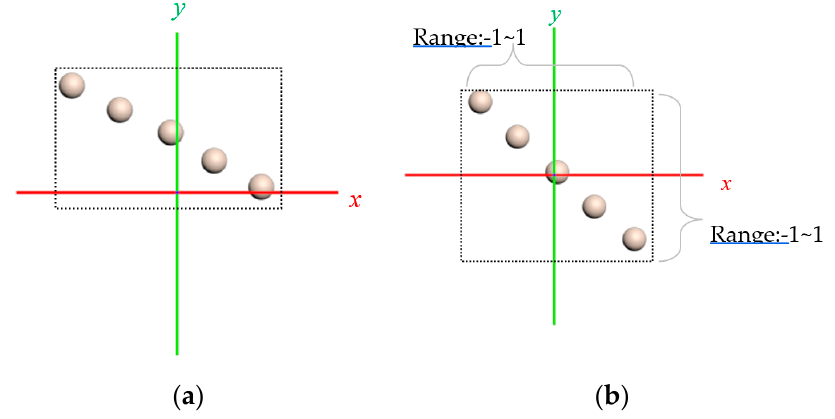
Figure 4. The normalization processes. ( a ) Before normalization and ( b ) after normalization.